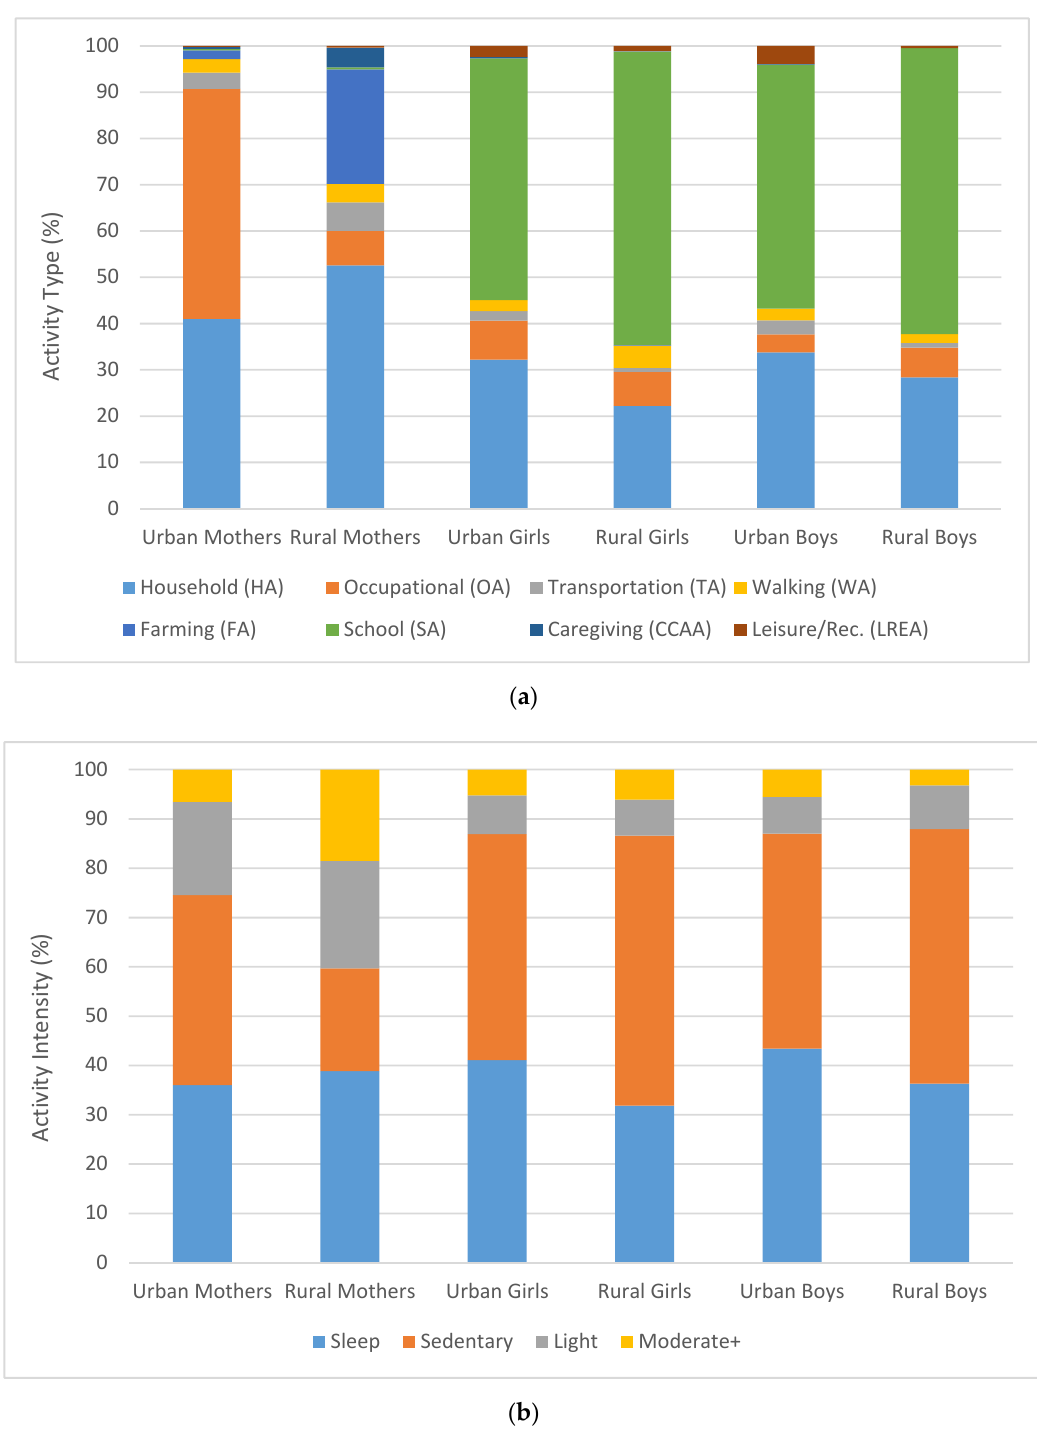
Figure 1. ( a ) Distribution of activities by domain for urban and rural mothers and their offspring. ( b ) Distribution of activities by intensity for urban and rural mothers and their offspring. See text for statistical details.